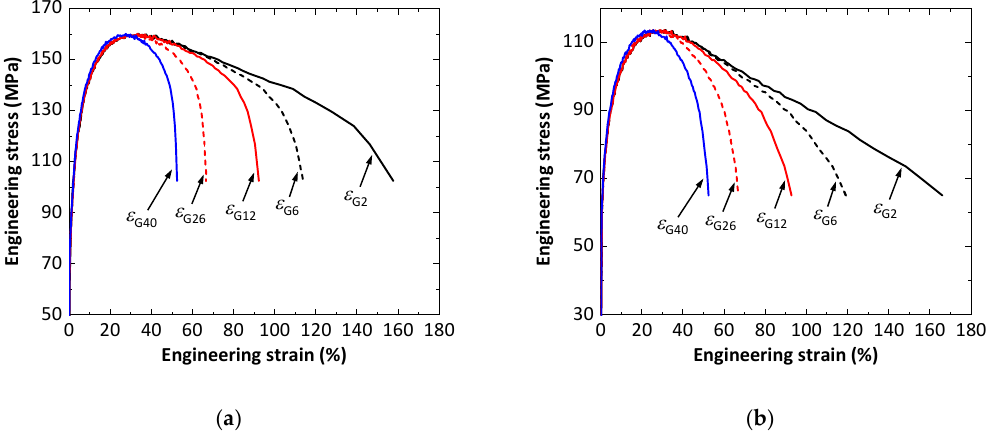
Figure 4. Engineering stress–strain curves of boron steel based on different gauge lengths under different test conditions [10]: ( a ) 750 °C and 0.2 /s and ( b ) 850 °C and 0.2 /s.